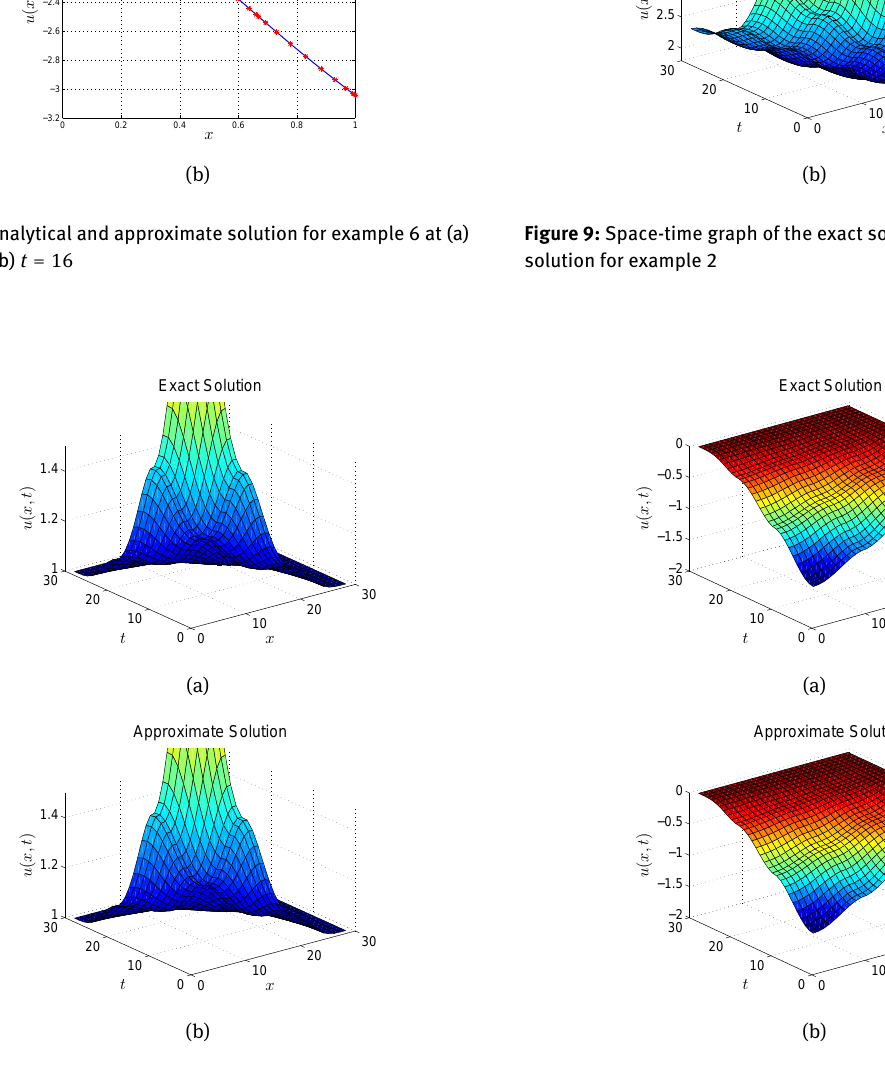
Figure 8: Space-time graph of the exact solution and approximate solution for example 1